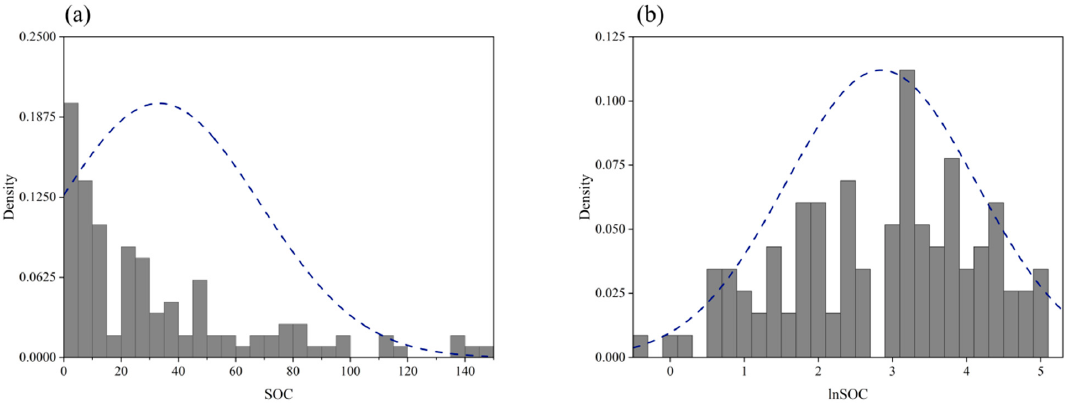
Figure 3. Frequency distribution of SOC ( a ) and lnSOC ( b